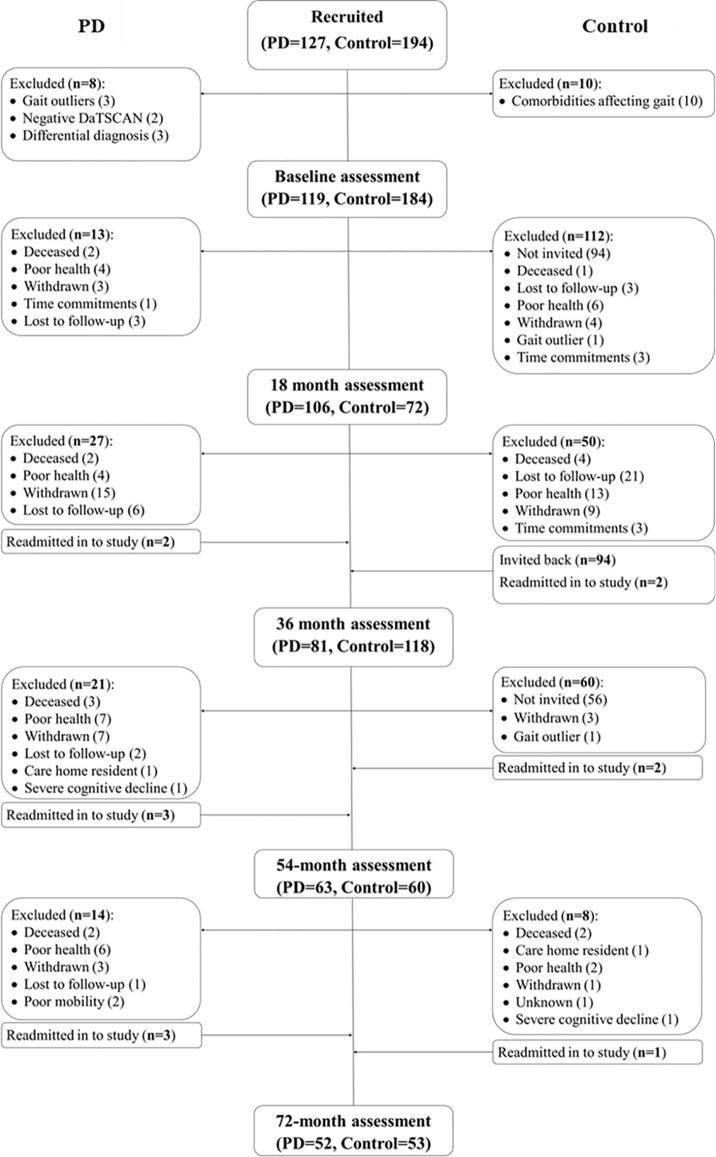
Flow chart indicating participant recruitment and attrition throughout the ICICLE-GAIT study. Some participants were readmitted into the study having previously withdrawn due to acute pain or illness.